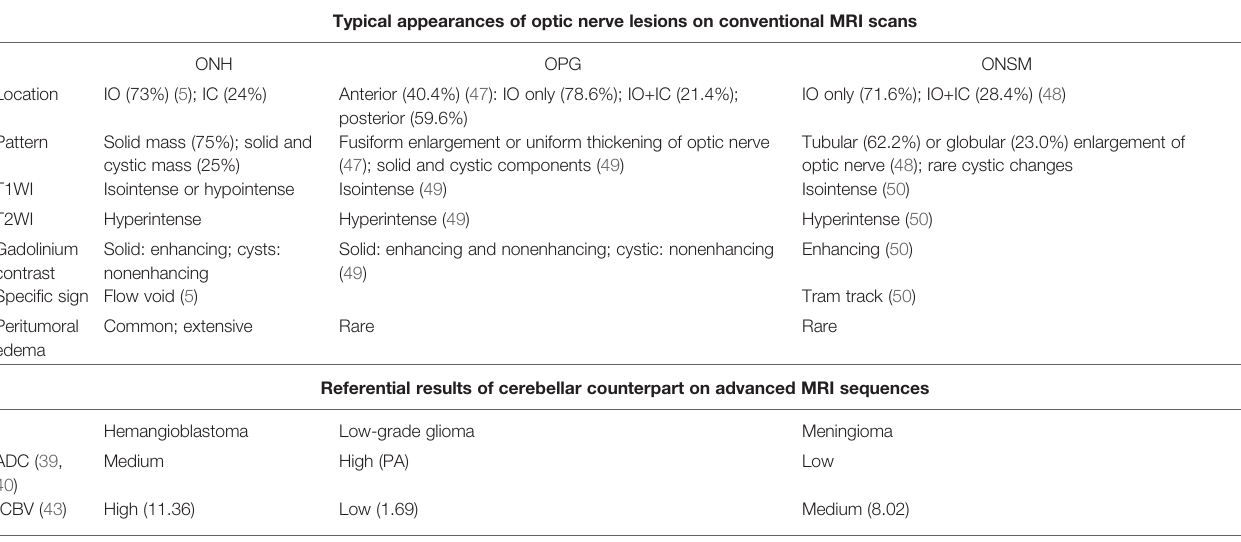
TABLE 2 | Differential diagnosis of ONH, OPG, and ONSM based on typical neuroimaging features. Typical appearances of optic nerve lesions on conventional MRI scans ONH OPG